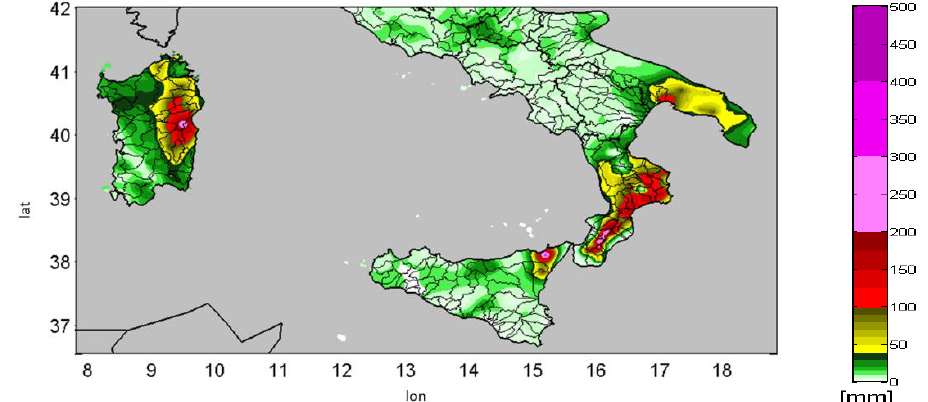
Figure A4. Example of fit of covariance kernel on the empirical 1D correlation.